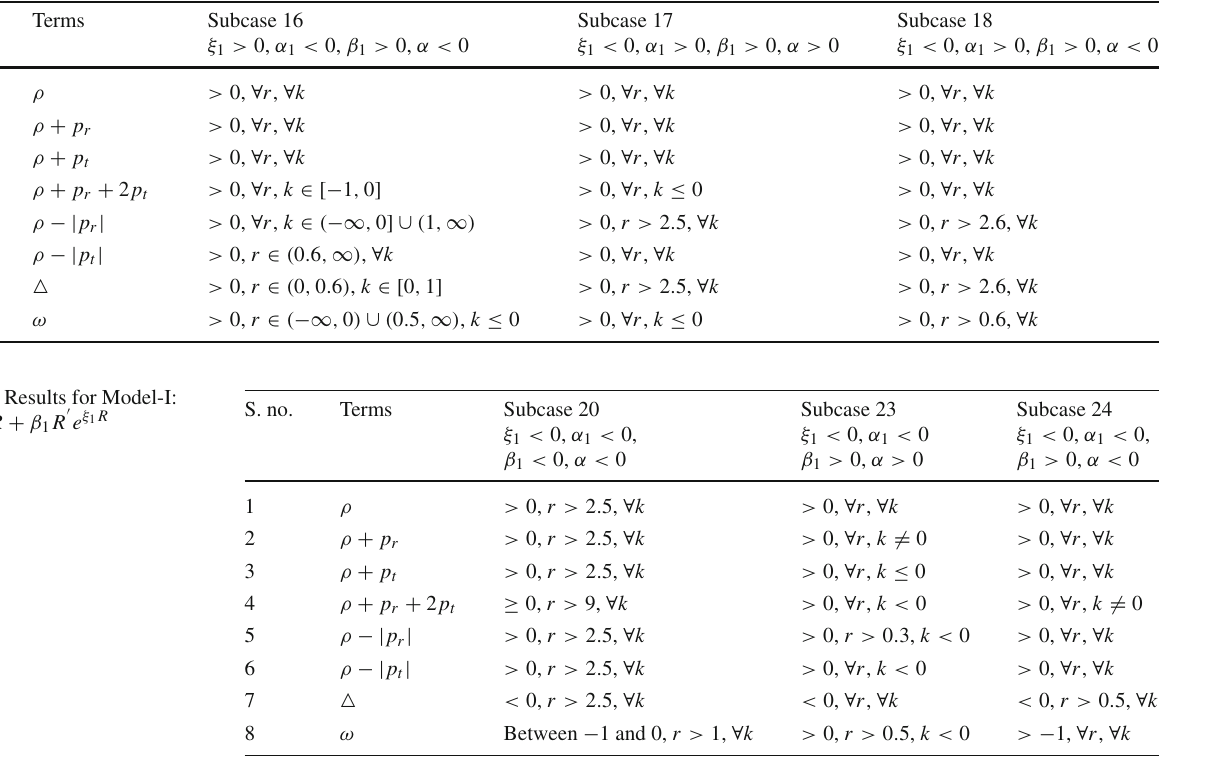
Table 4 Results for Model-I: ρ = α 1 R + β 1 R (cid:2) e ξ 1 R S. no.